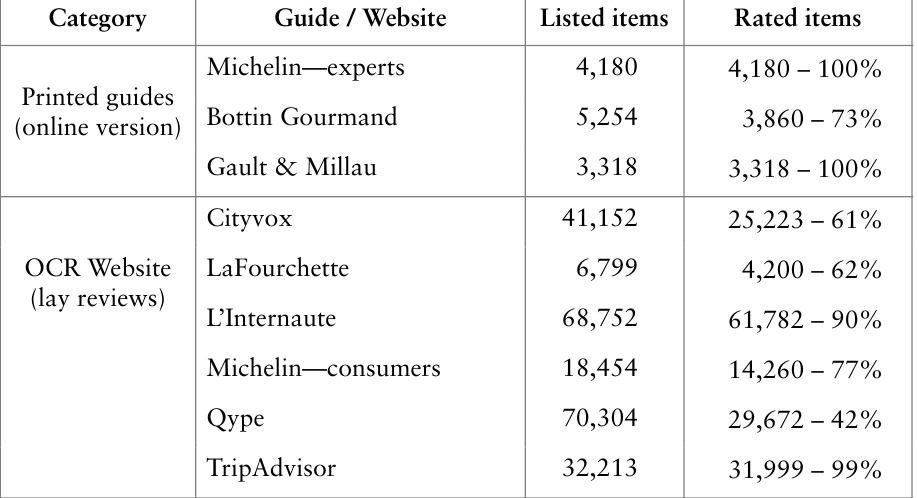
Table 3. Number of listed and rated restaurants on a selection of websites—online version of printed guides and OCR websites.